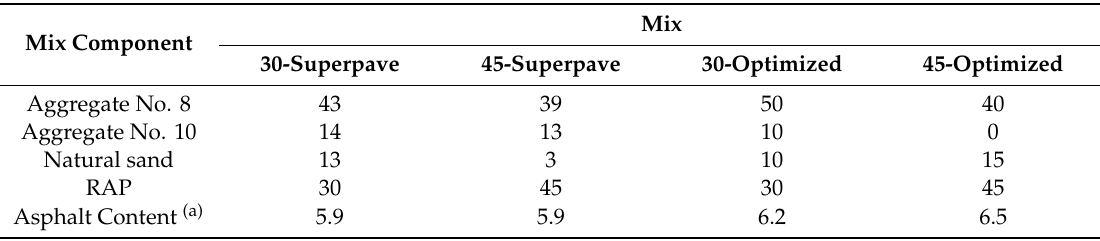
Table 2. Breakdown of mixes’ composition.